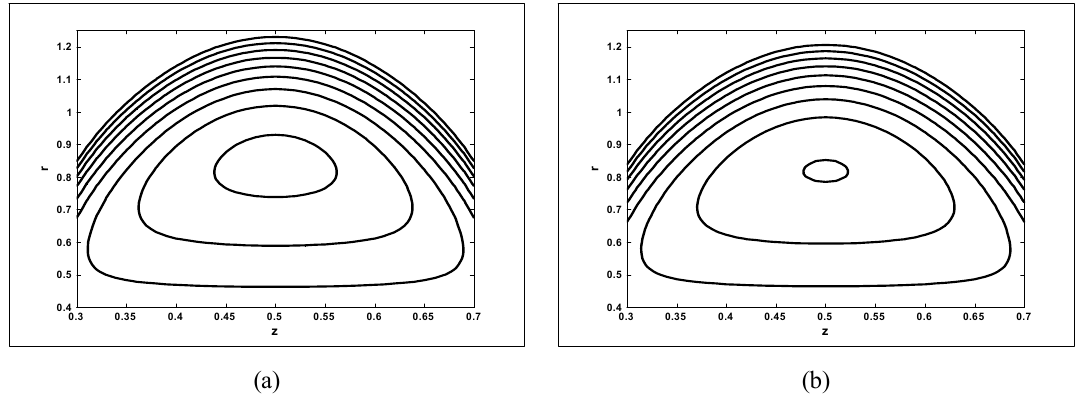
Figure 15. Streamlines for two different values of M for ( a ) M = 1 and ( b ) M = 0.6. The other parameters are chosen as ϕ = 0.2, Q = 0.45, r 1 = 1 when µ = r .